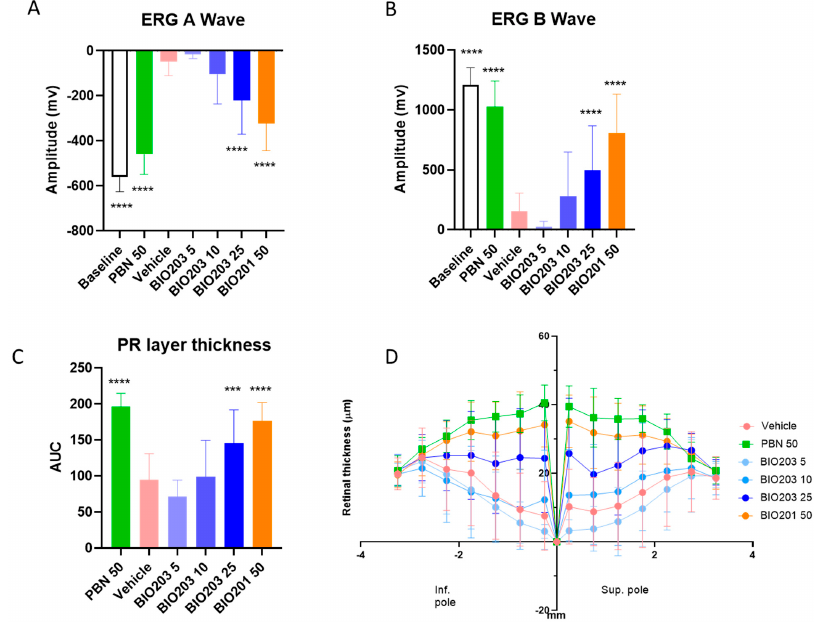
Figure 6. Effect of norbixin and BIO203 on ERG and retinal phototoxicity after BLD in albino rats. ( A ) Photopic A wave and ( B ) Photopic B wave, ERG recorded 7 days after blue-light illumination. ( C ) Graph showing the number of photoreceptor layers measured along the retina, each 200 μ m from the optic nerve. ( D ) Histograms showing the area under the curve (AUC) calculated from the photoreceptor layer quantification and used to perform statistical analyses. The doses of PBN (used as a positive control), BIO203, and norbixin are expressed in mg/kg. Bars represent mean ± s.e.m. with n = 10 animals per group (20 eyes analyzed). *** p < 0.001, **** p < 0.0001 compared to the vehicle group (One-way ANOVA, Dunnett’s post-test). 2.4. Effect of 6 Months BIO203 Oral Treatment by Complementation in 11–12-Month-Old Abca4 − / − Rdh8 − / − Mice